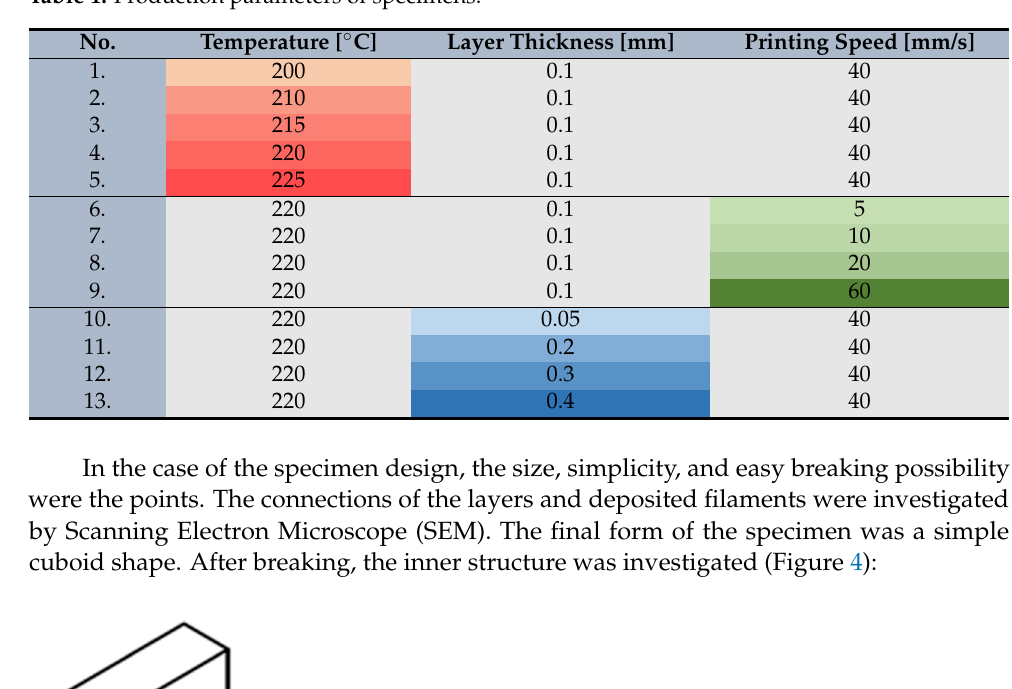
. Figure 5. CT picture of a specimen. 3. Results The effect of the three influencing factors can be determined based on our investiga- tion. 3.1. Layer Thickness Failure increase is observable in pictures produced by SEM technique in the same dimension scale of layer thickness of 0.2 mm and 0.3 mm (Figure 6):